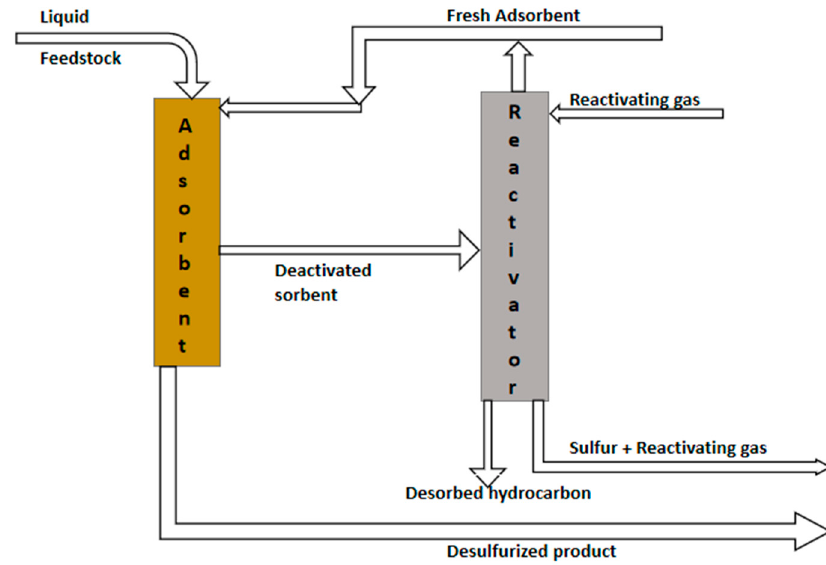
Figure 2. Adsorptive Desulfurization fl ow